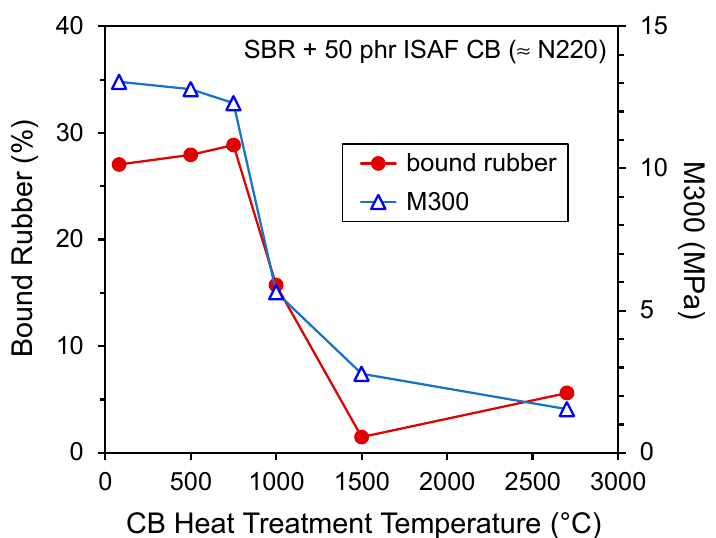
Figure 13. Bound rubber and M300 for SBR filled with ISAF CB ( ≈ N220) versus CB heat treatment temperature. Results are replotted from Dannenberg [65].